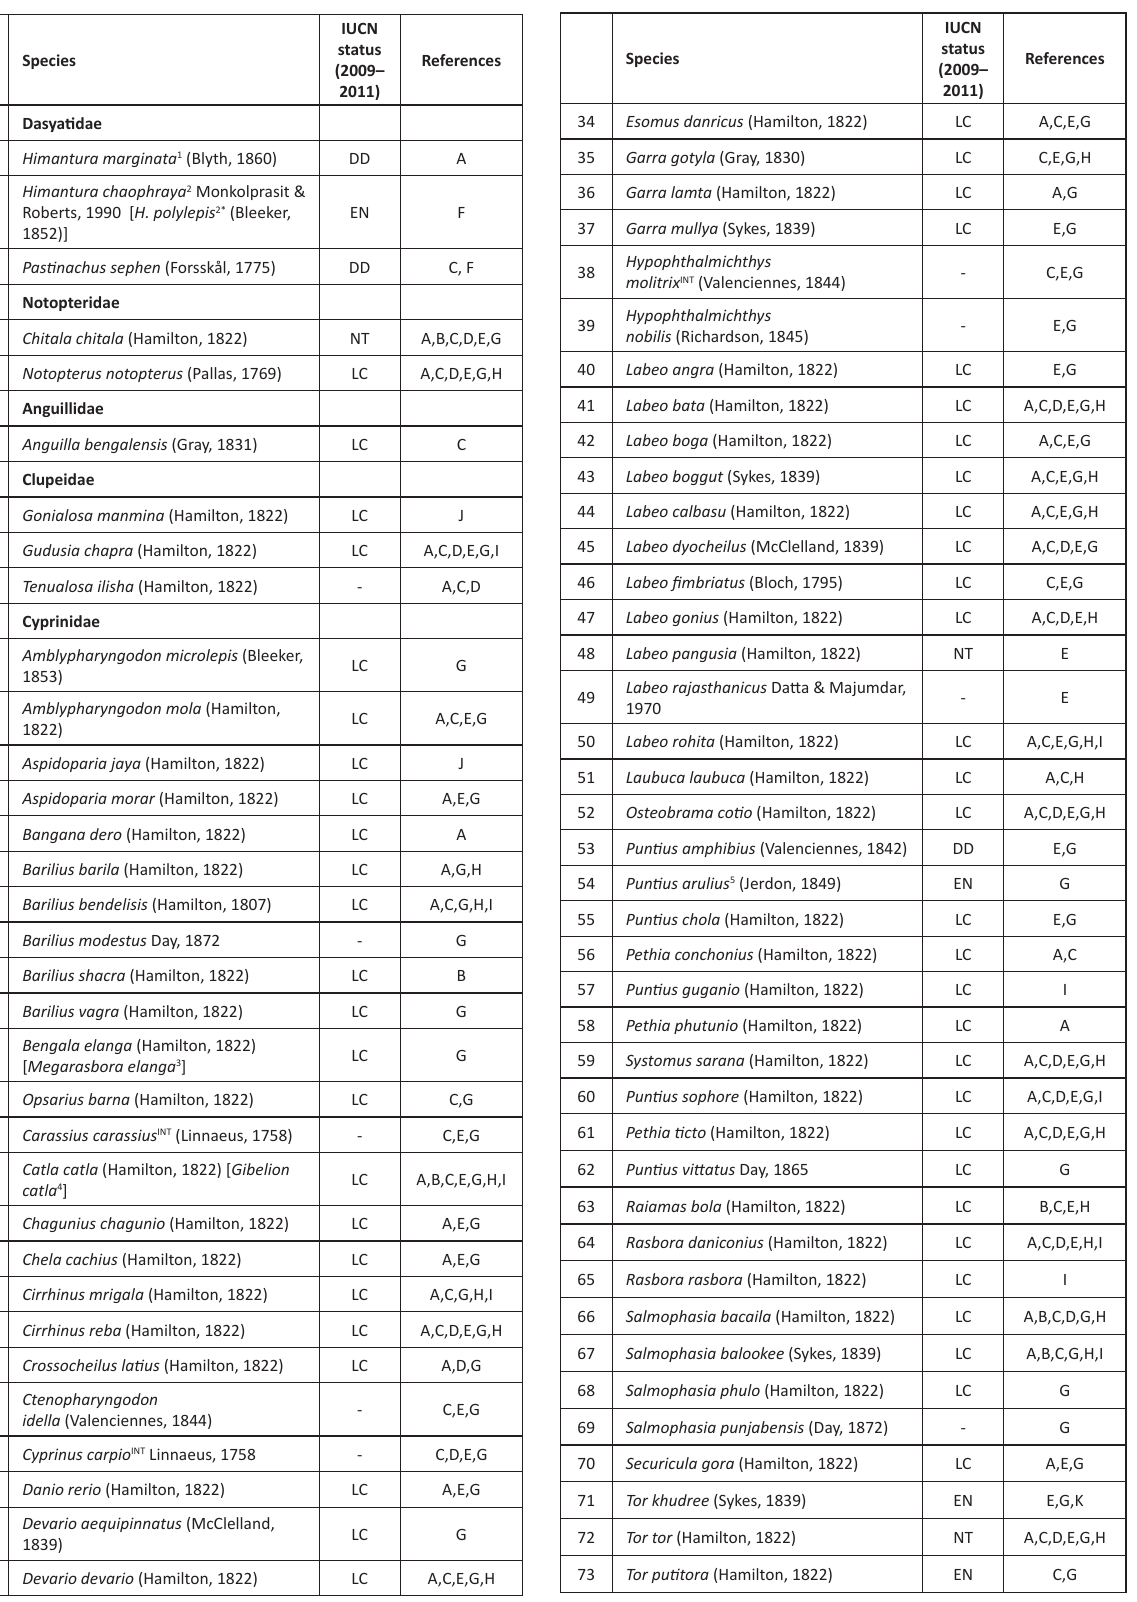
Table 2. Checklist of fishes of the Chambal River